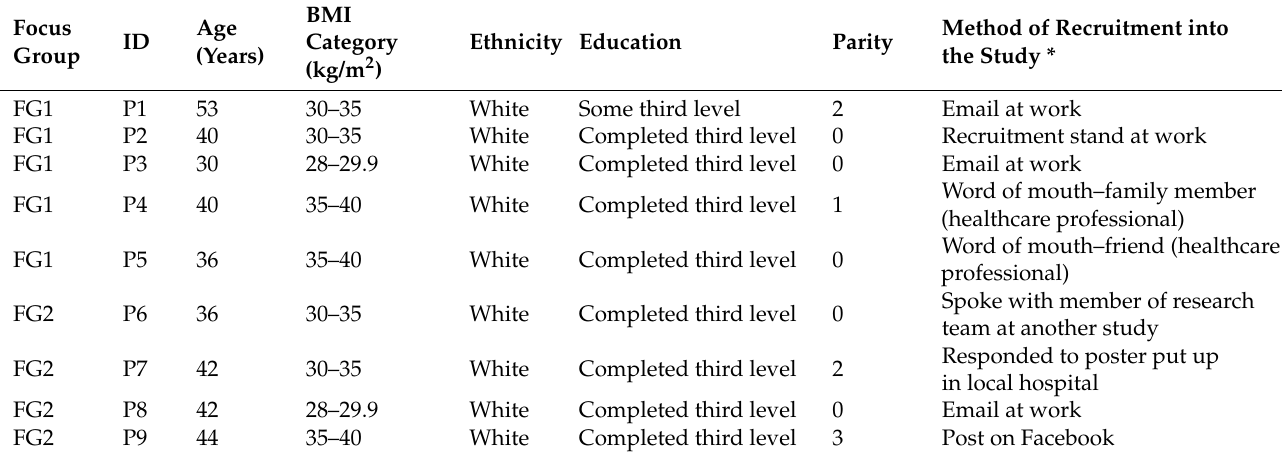
Table 2. Characteristics of the focus group